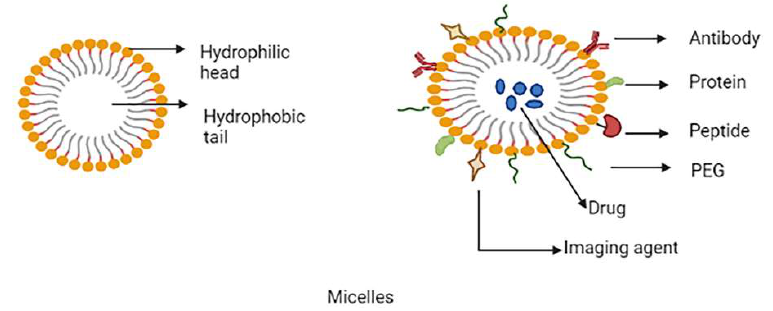
Figure 4. Schematic representation of multifunctional